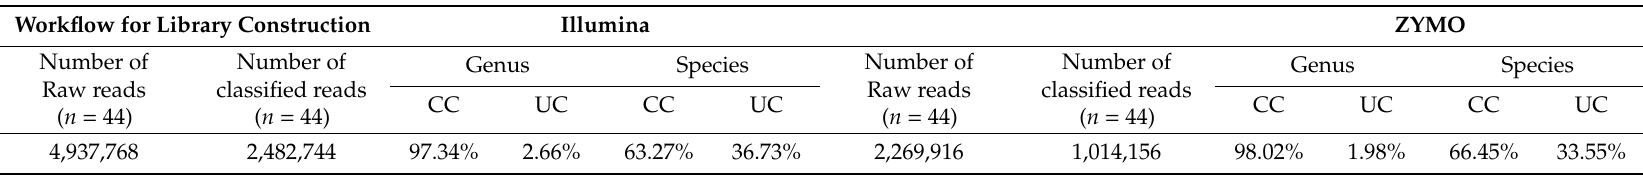
Table 1. Classification results of short-read amplicons with SILVA database for taxonomic assignment at genus or species levels using distinct workflow for library